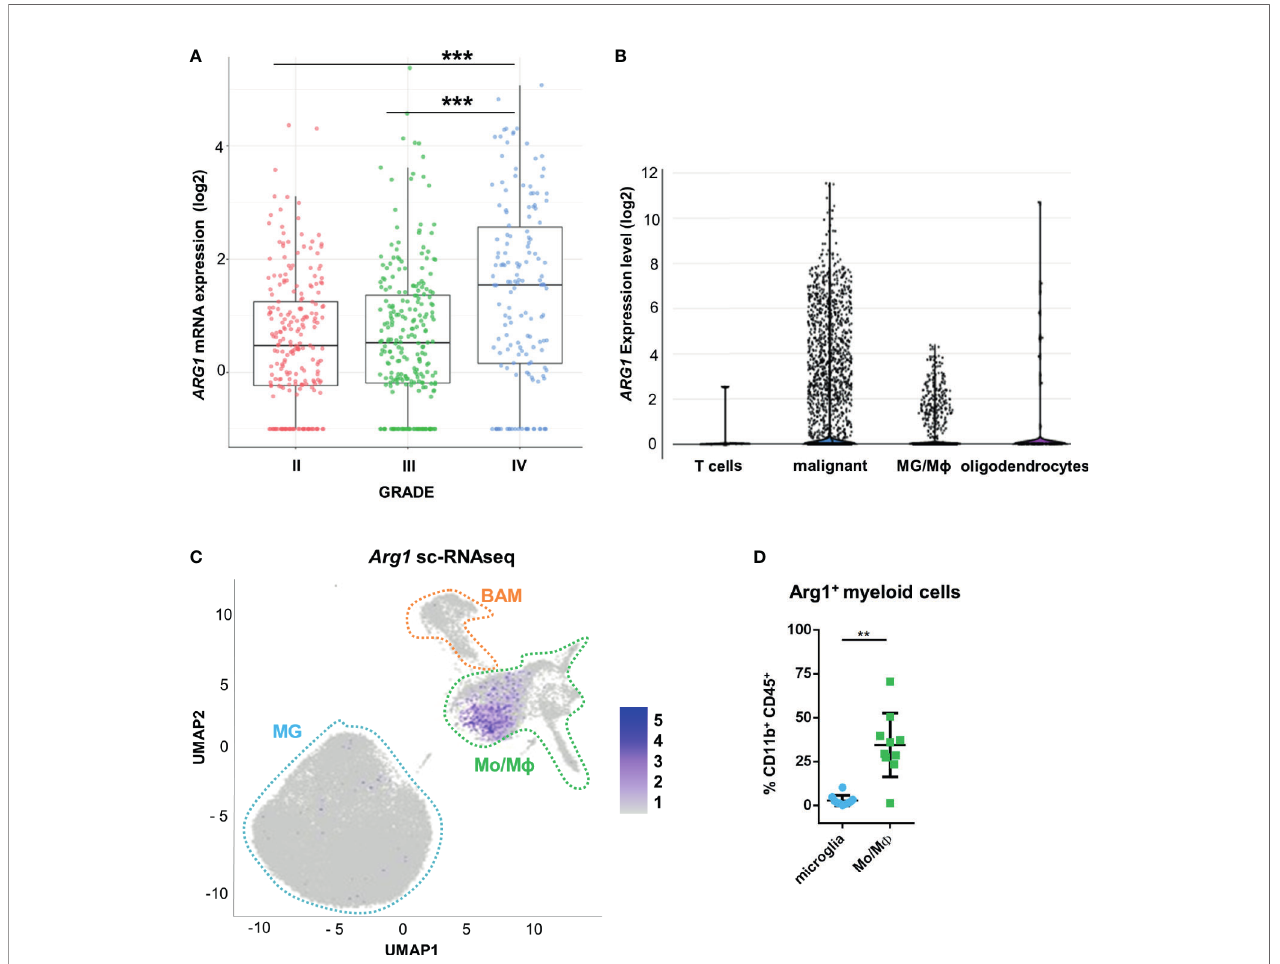
FIGURE 1 | ARG1 expression is highly upregulated in human glioblastomas and murine experimental gliomas. (A) ARG1 expression in gliomas of different WHO grades (WHO grades II- IV) in TCGA datasets. Statistical signi fi cance was determined by Tukey ’ s Honest Signi fi cant Difference (HSD). ***p < 0.001. (B) Expression of ARG1 in malignant cells and microglia/macrophages (MG/M F ) in 10 samples of astrocytomas in single-cell RNA-seq datasets (public data) from Ref. (33). (C) UMAP plot of CD11b + cells from GL261 gliomas (n=8). Projection of cells combined from clusters identi fi ed as microglia, monocytes/macrophages (Mo/M F ), and BAMs. Plots depicting Arg1 mRNA which is highly expressed in in fi ltrating Mo/M F . (D) Flow cytometry analysis of Arg1 expressing cells among microglia (CD11b + CD45 lo ) and Mo/M F (CD11b + CD45 high ) cells sorted from murine gliomas (n=10); Wilcoxon matched-pairs signed rank, two-tailed, **p <